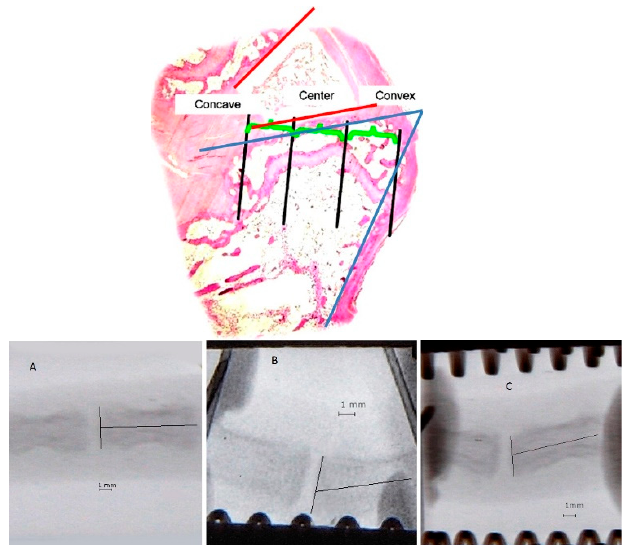
Figure 8. Photograph of a histological slide of the endplate divided into three parts: concave, central, and convex. Visible wedging of the vertebra (blue angle) and deformed disc (red angle). H&E 20× staining. Photograph of a vertebra X-ray image in group I ( A ), group II ( B ), and group III ( C ). Three measurement areas were distinguished in each part. The upper endplate of the hypertrophic layer was identified as the first chondrocyte layer. The lower endplate was constituted by the farthest intact chondrocytes on the epiphysis. After determination of nodal points, curves connecting these points were created. The height of the hypertrophic zone was measured as the distance between the points of the curve along the long axis line perpendicular to the epiphysis. The scheme of the hypertrophic zone measurement is shown in Figure 9.